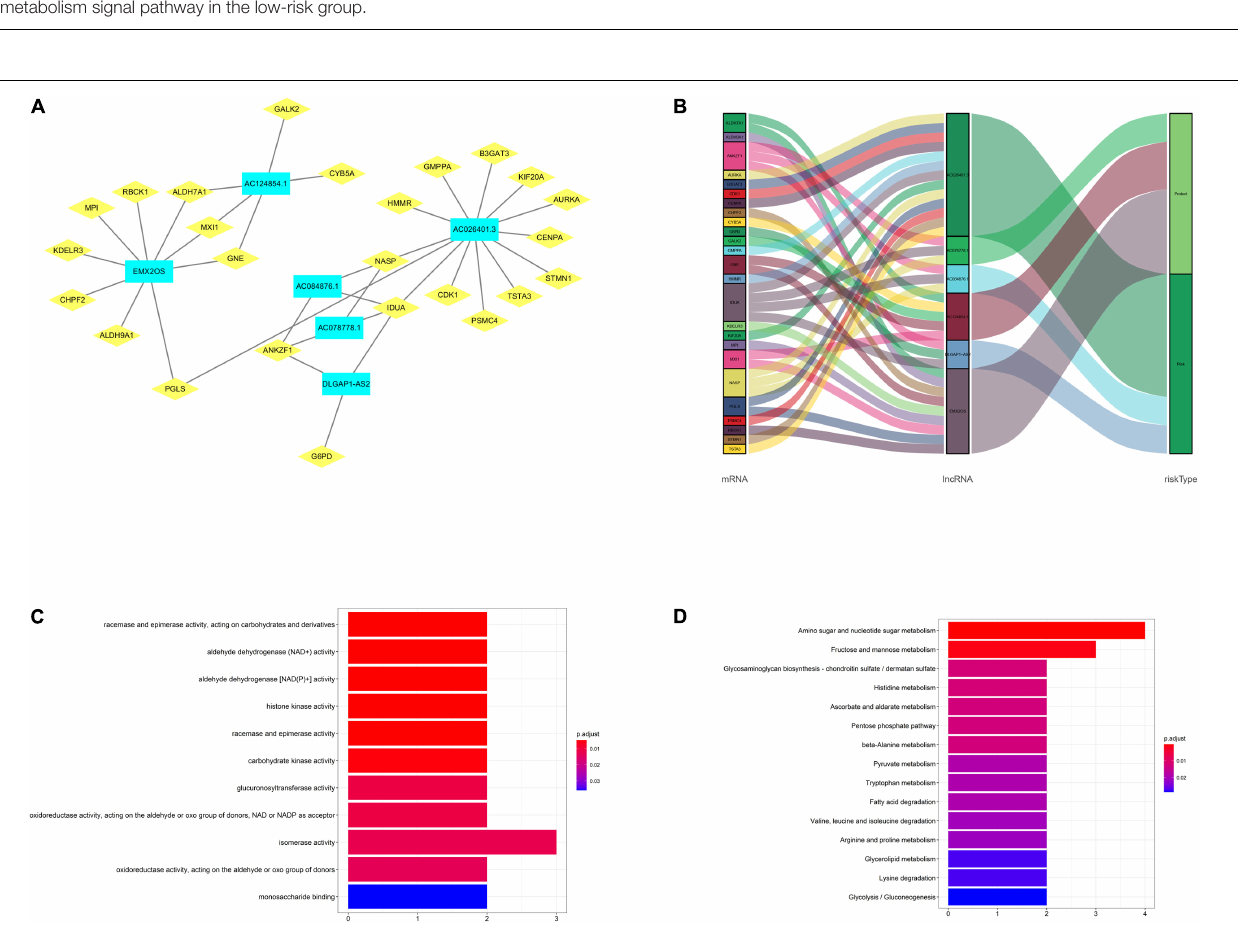
FIGURE 6 | Gene set enrichment analysis of glycolysis-related gene sets between the high- and low-risk groups. (A) The results show significant enrichment of energy metabolism related signal pathway and cancer signal pathway in the high-risk group. (B) The results show immune related signal pathway and amino acid metabolism signal pathway in the low-risk group.